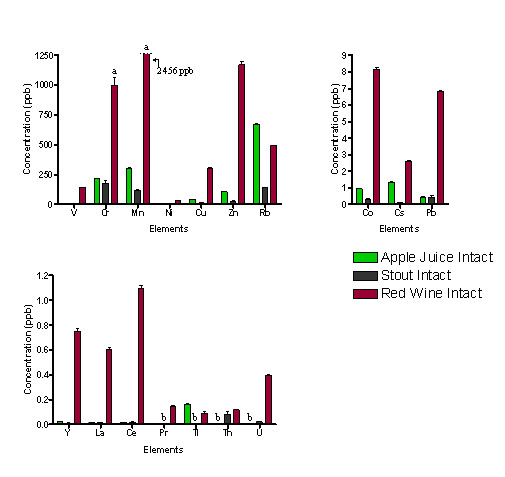
ICP-MS results for intact beverages in the concentration ranges of high (up to 1250 ppb); medium (up to 9 ppb); low (up to 1.5 ppb). a = above working range.